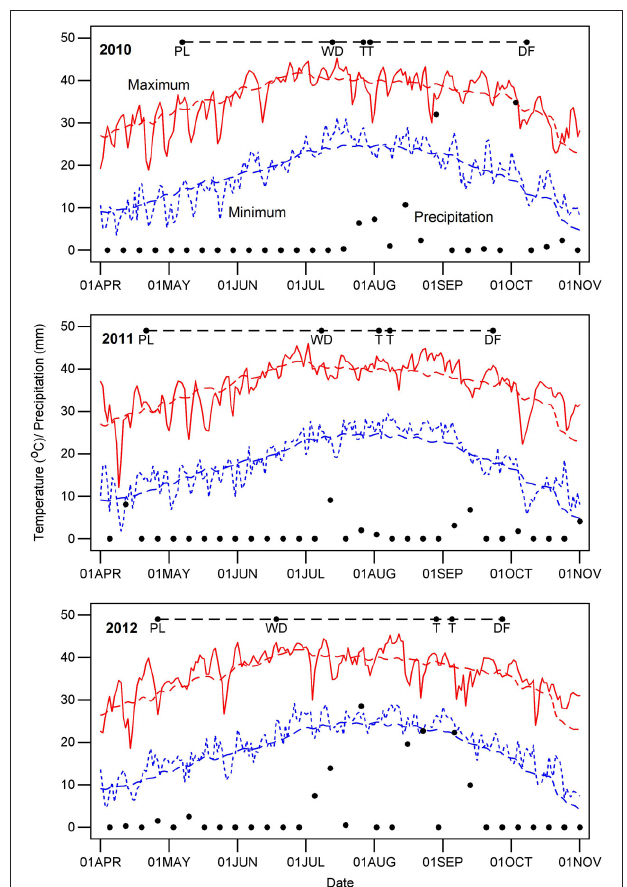
FIGURE 1 | Daily weather during the 3 years of cotton experiments. Letters along the dashed line at the top of the graph for each year indicate the time from planting (PL) to chemical defoliation (DF), the date that the water-limited irrigation regime was initiated (WD) and the start and end dates for measurements of leaf thickness (T). The red and blue colored lines represent the maximum and minimum air temperature, respectively. Black dots denote the precipitation amounts and days on which it